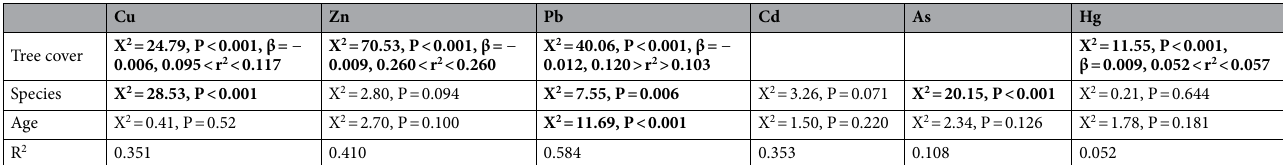
Statistical analyses. Statistical analyses were performed using R software (version 4.0.3) 51 . The percentage of data above the MTE quantification limit were similar between blue tits and great tits. Overall, they were 100% for Zn, 99% for Cu, 92% for Pb, 91% for As, 59% for Cd and 21% for Hg. Data below the quantification limits were given a value using a regression on order statistic (‘ROS’ function of the ‘NADA’ package); this estimation was done separately in blue tits and great tits 52 . To minimize the influence of possible spurious outliers on the distribution of MTE concentrations, values more than 1.5 times the interquartile range from the quartiles (i.e. either below Q1 − 1.5IQR, or above Q3 + 1.5IQR) were removed 53 ; the procedure was done separately for blue tits and great tits on log-transformed values. In total, 16 values (ca. 1.5% of the values) were identified as outliers. Note that, although the output of the models slightly changed, the results are the same whether outliers were removed or not (see Table B1). MTE concentrations in blue tit and great tit feathers were compared using linear mixed-effects models with the explanatory variable. MTE concentrations may vary differently in response to bird moulting pattern, forag- ing behaviour, seasonal movements and/or MTE metabolism. Those are known to differ between species and age 43,44,54–56 . Therefore, species, age, their interaction as well as their interactions with the urbanization level were added as explanatory variables and the single terms “species” and “age” were considered as categorical control variable. The location (i.e. either the city or the protected forest) was added as random intercept. Lmer were fitted with restricted maximum likelihood (REML) method using the ‘lme4’ package. Normality of model residuals was validated using quantile–quantile plots. For each model, we performed a backward stepwise selection using the AIC 57 . A Type III Wald Chi-square test Anova was used to determine the significance of retained variables in the final models. When discrete explanatory variables were retained in the models, contrasts among groups were tested using least-square mean pairwise comparisons (contrast function of the ‘lsmeans’ package) 58 . The proportion of variance in MTE concentrations that is explained by urbanization level (computed either from tree cover, impervious surface cover or urbanization score) was calculated using the ‘r2_nakagawa’ func- tion of the ‘performance’ package. It was calculated using two metrics of relative importance: (i) the difference between the conditional r-squared of the full model and the conditional r-squared of the model without the urbanization index as explanatory variable (defined as the “last” metric in the ‘relaimpo’ package) and (ii) the marginal r-squared of the model including the urbanization index only as explanatory variable (defined as the “first” metric in the ‘relaimpo’ package) 59 . The “last” and the “first” metrics tend to underestimate and overes- timate, respectively, the variance explained by the variable of interest (here the urbanization index), meaning that the exact variance explained by the urbanization index falls between the two values computed from those two metrics 59 . To further investigate what environmental variable(s) better explain(s) the variation in MTE concentrations, the two metrics were also computed for the distance to the closest road and the distance to the city centre (Table D2).